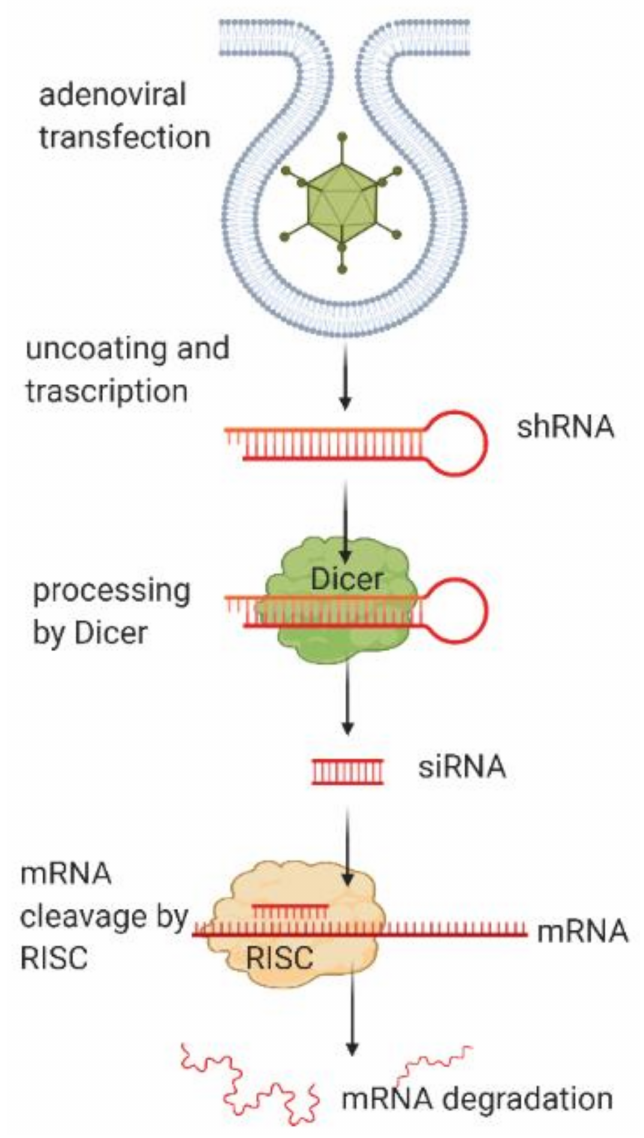
Figure 2. Mechanism of action of adenoviral particle